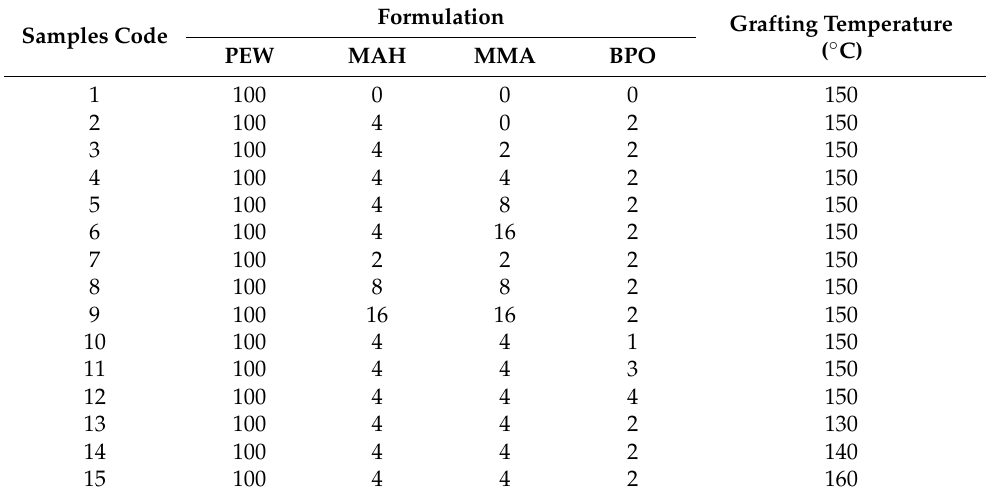
Table 1. Formulation and grafting temperature of the modified polyethylene